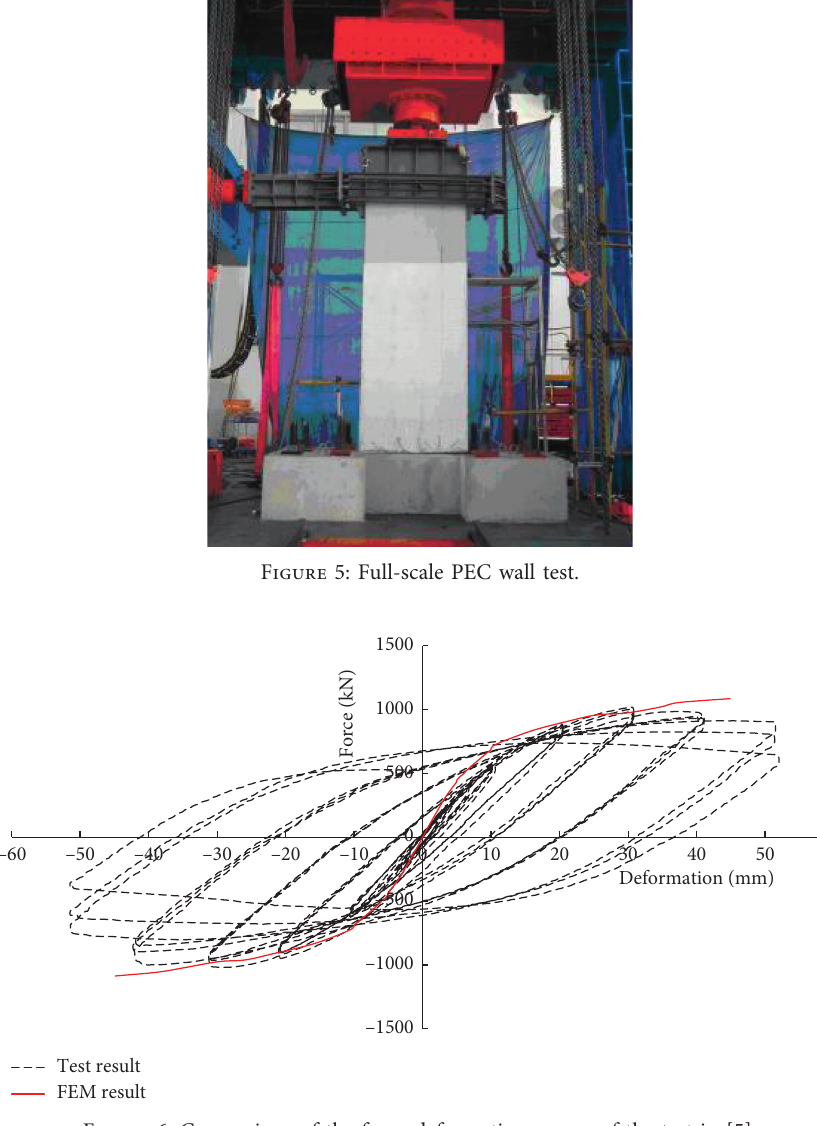
Figure 6: Comparison of the force-deformation curves of the test in